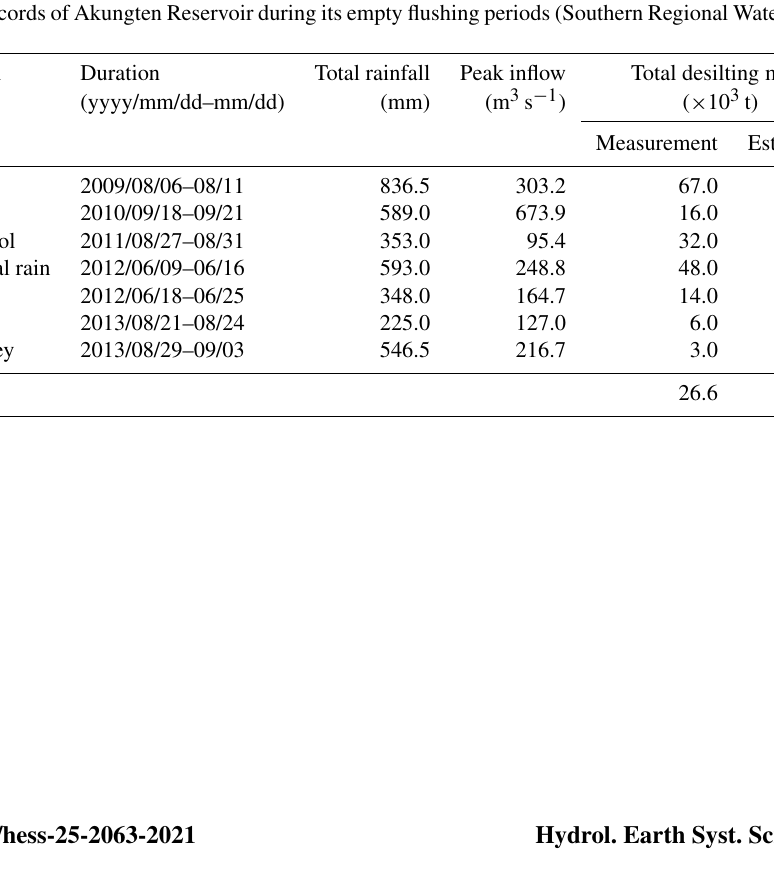
Table A2. The operating records of Akungten Reservoir during its empty flushing periods (Southern Regional Water Resources Office,